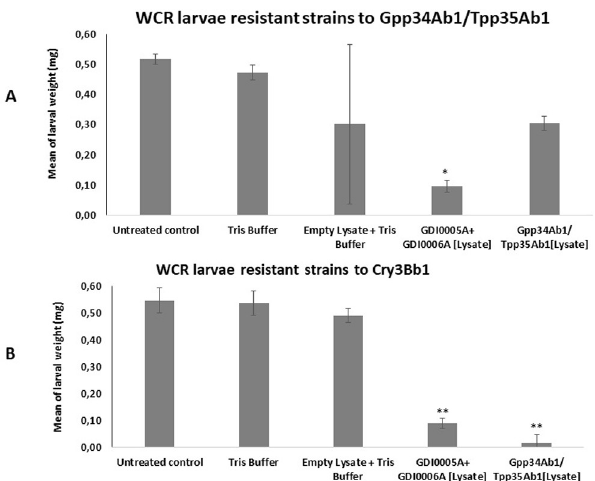
Fig 3. Activity of GDI0005A and GDI0006 proteins produced in Escherichia coli on resistant western corn rootworm (WCR) larvae using diet overlay bioassays. (A) WCR strain resistant to the insecticidal